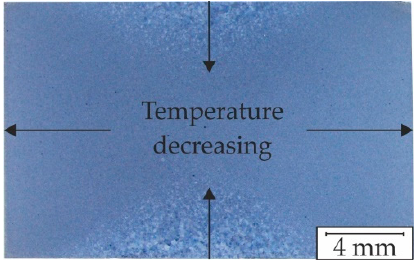
Figure 4. Stereographic image of sintered GE48 powder.